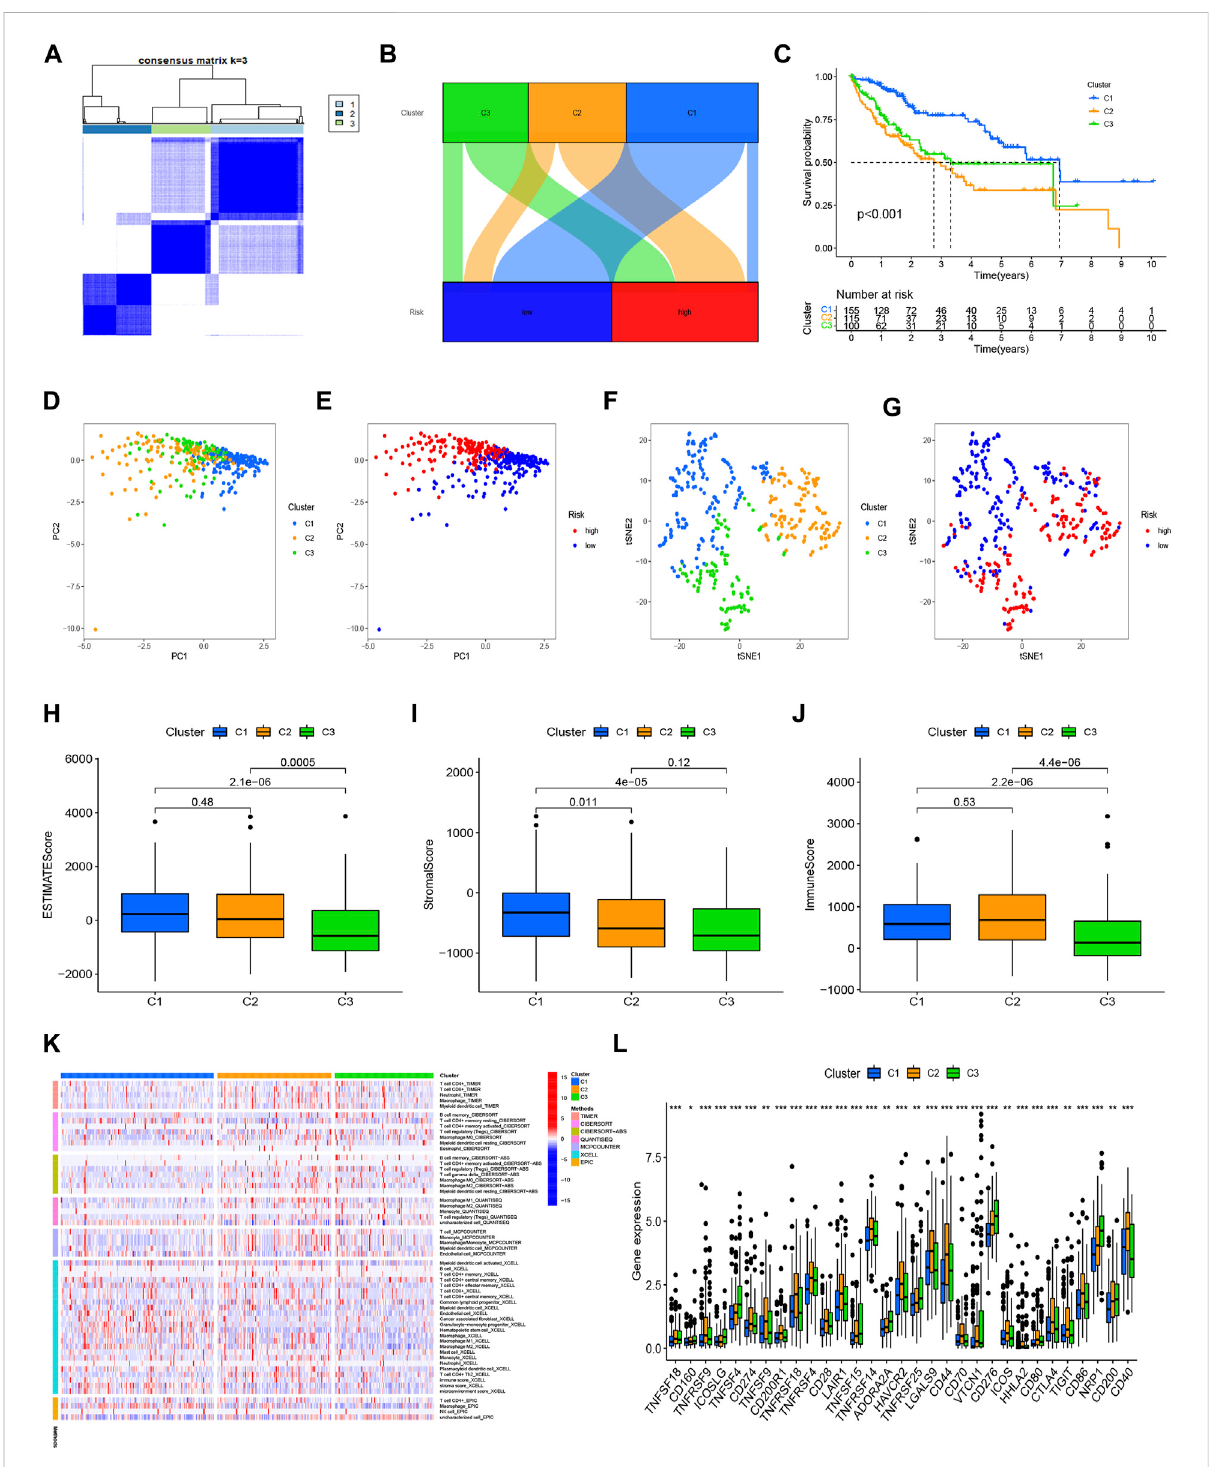
Clusters analysis. (A) Patients divided into three clusters; (B) Sankey diagram; (C) K-M survival curves of OS in clusters; (D,E) The PCA of risk groups and clusters; (F,G) The t-SNE of risk groups and clusters; (H – J) Immune-related scores in clusters; (K) Heatmap of immune cells in clusters; (L) Different expression of checkpoints in